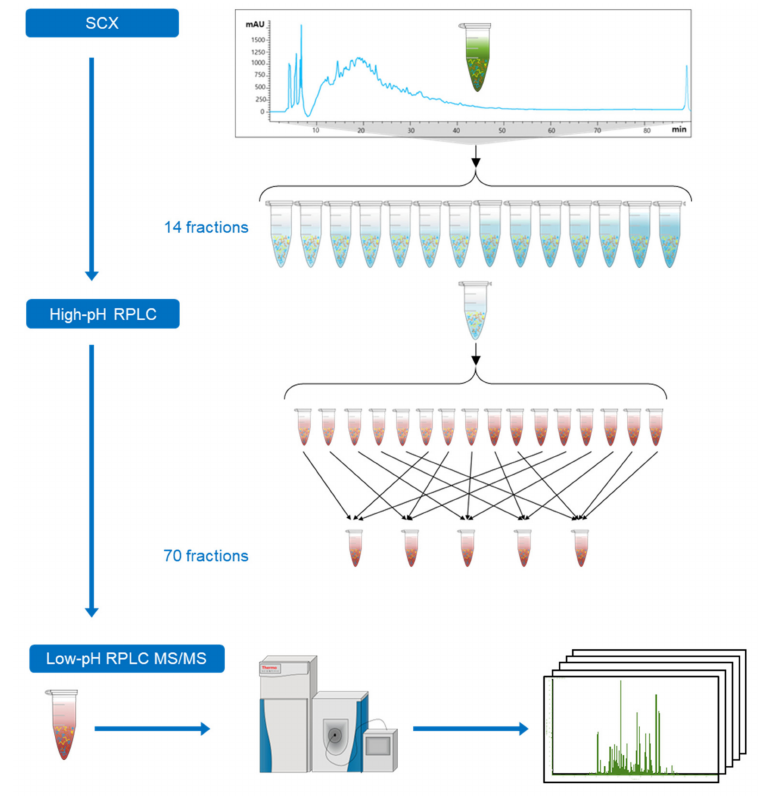
Figure 1. Workflow of proteomic analysis of Emiliania huxleyi (E. huxleyi) using three-dimensional liquid chromatography (3D-LC) system. The proteome digest of E. huxleyi (CCMP371) cell lysates